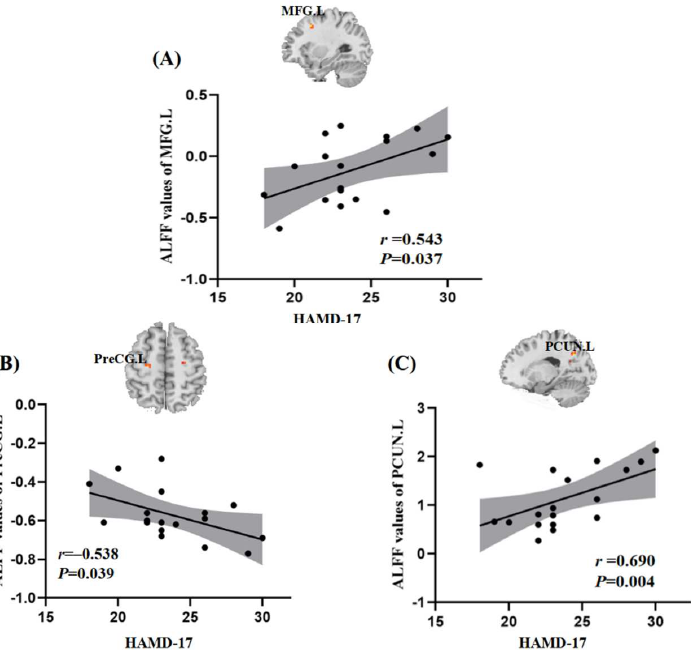
Figure 3. Relationships between ALFF and clinical symptom. Positive correlation between the ALFF values and HAMD-17 scores in the female TRD group: ( A ), MFG.L, Left middle frontal gyrus; ( C ), PCUN.L, Left precuneus. Negative correlation between the ALFF values and HAMD-17 scores: ( B ), PreCG.L, left precentral gyrus. HAMD-17, 17-item Hamilton Rating Scale for Depression.